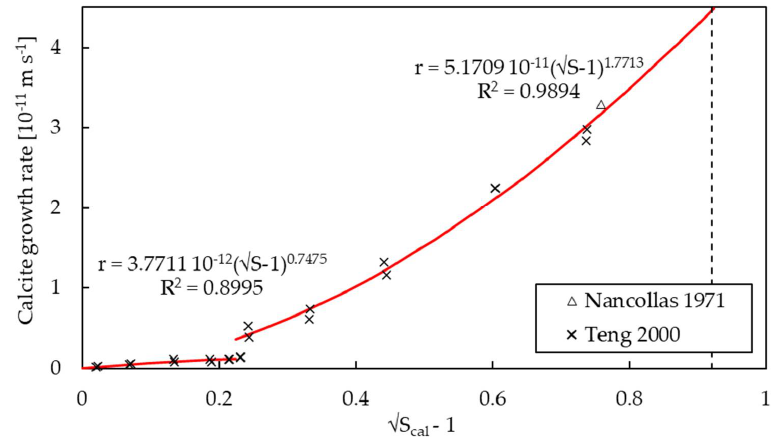
Figure 2. Calcite growth separated in spiral growth (S cal ≤ 1.514) and mixed growth (S cal ≥ 1.549). The dashed black line indicates where vaterite becomes supersaturated. This gives two sets of parameters, one for each of the different calcite growth mechanisms.